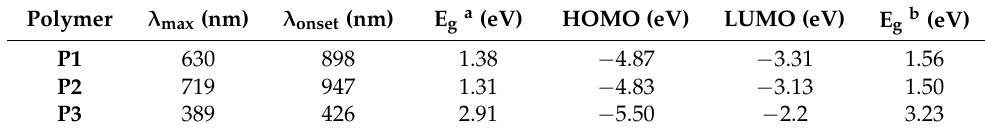
Table 1. Optical properties and HOMO and LUMO energy levels of P1 , P2 , and P3 .